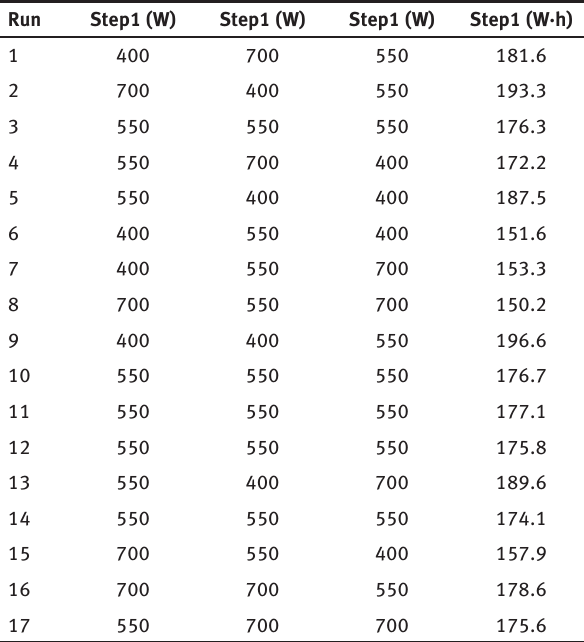
Table 5: Experimental design matrix and